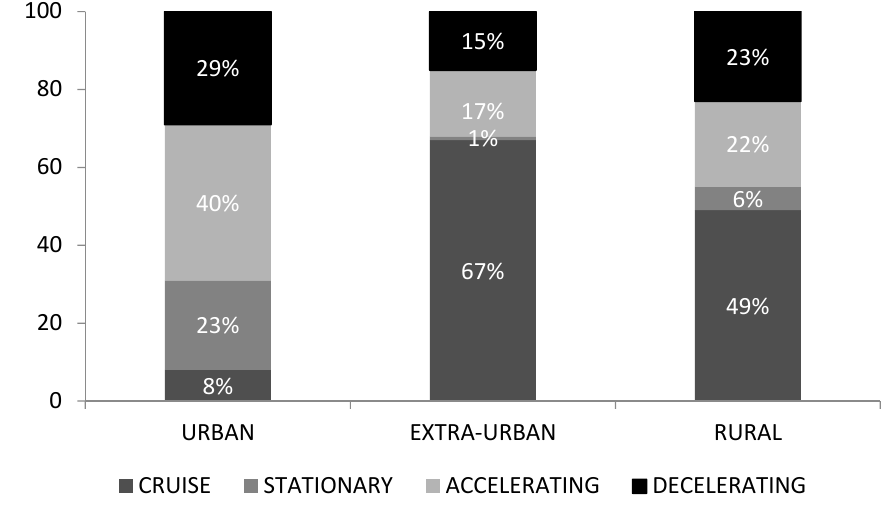
Figure 3. Mobility activity in different routes.